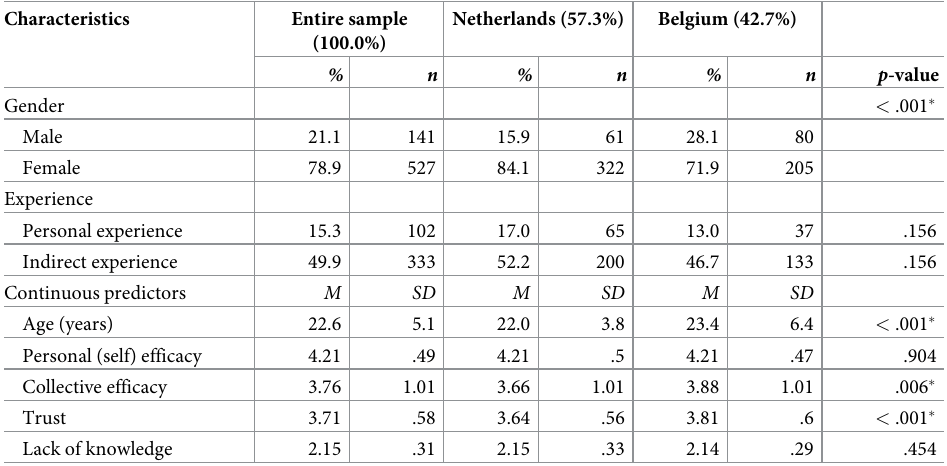
Table 1. Descriptives of the sample (N =